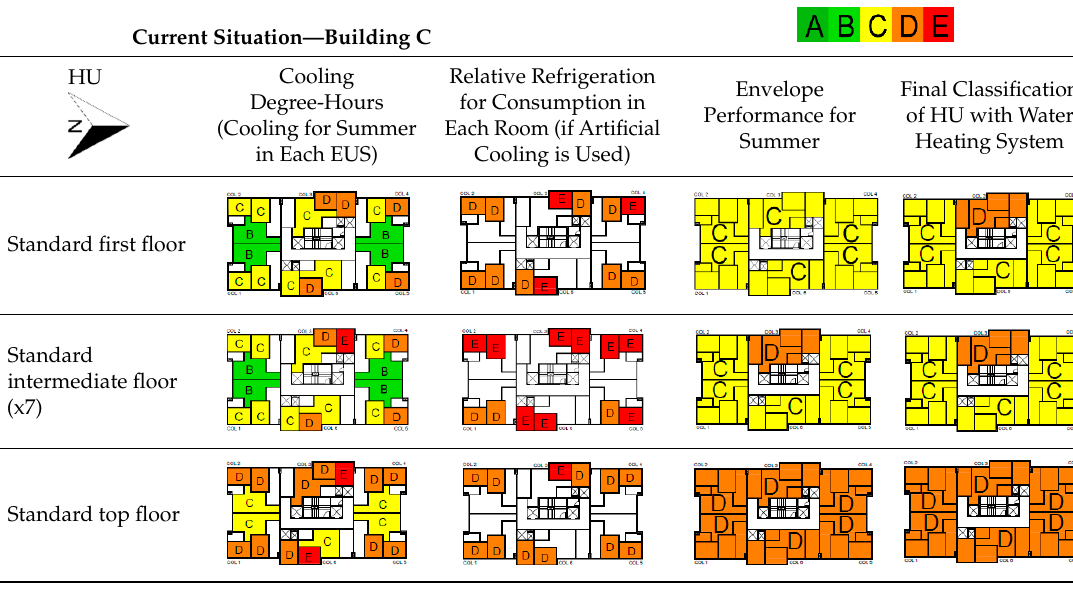
Table 5. Graphical representation of the standard floor of Representative Building A with the classification based on energy efficiency assessment.